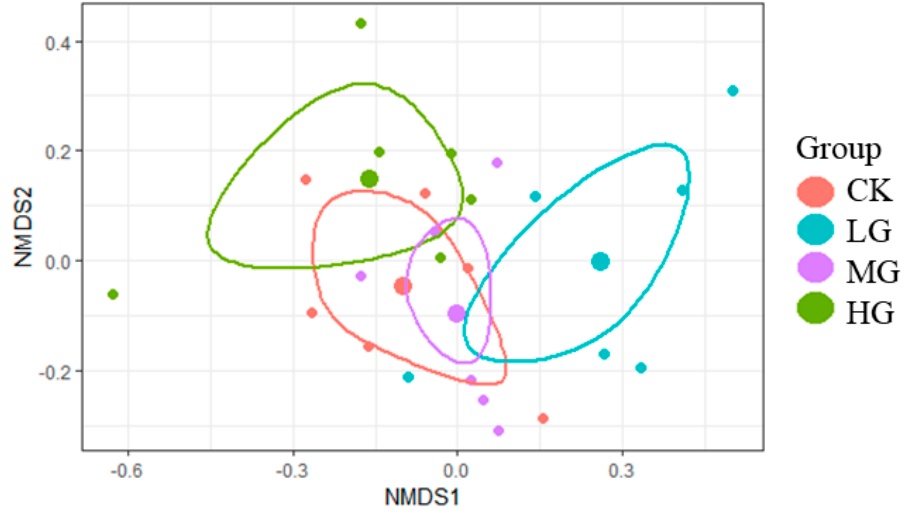
Figure 2. NMDS analysis of the plant community based on the data of the species importance value (IV) with different grazing intensities. Dots of the same color represent the same level of grazing intensity. Each small dot indicates a treatments replication, and each large dot shows the mean value of the treatments. Circles represent the 95% confidence of the mean value. CK, no grazing; LG, light grazing; MG, moderate grazing; HG, heavy grazing.